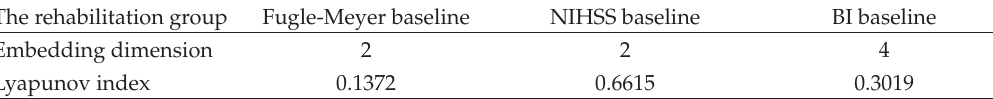
Table 3: Lyapunov time series index table of the rehabilitation group for unit cost e ff